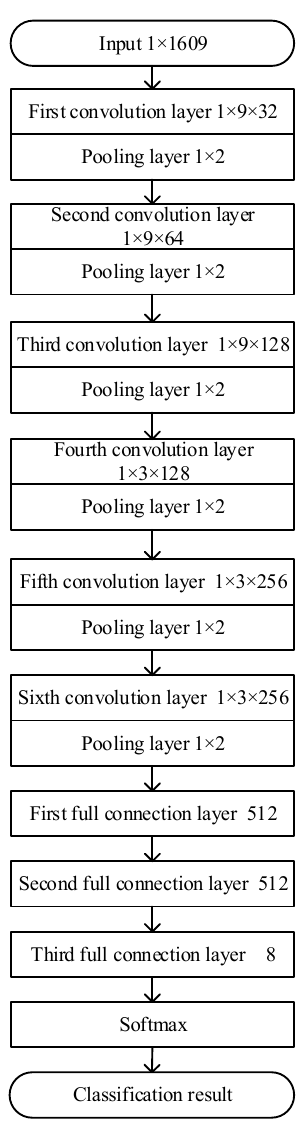
Figure 4. Schematic diagram of convolutional neural network (CNN) based on batch normalization.